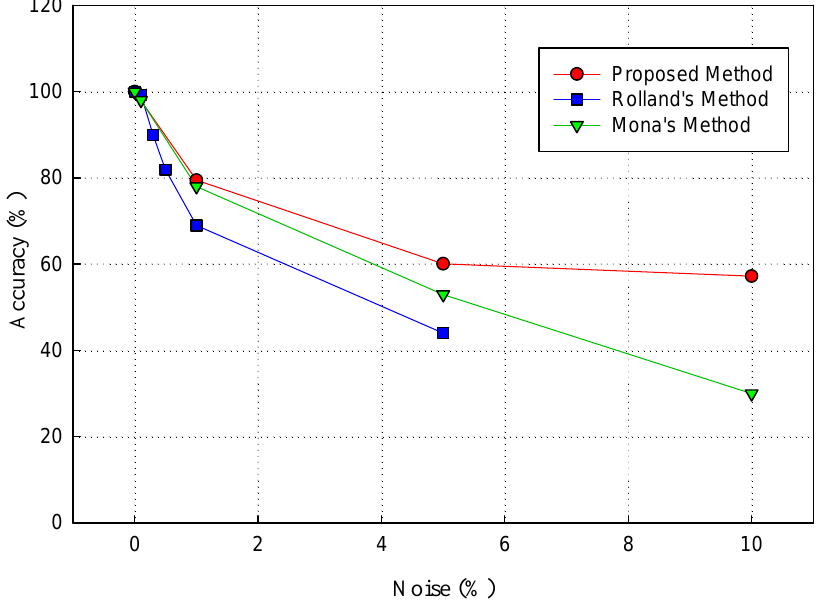
Figure 9. Robustness of the proposed method with noise attack.